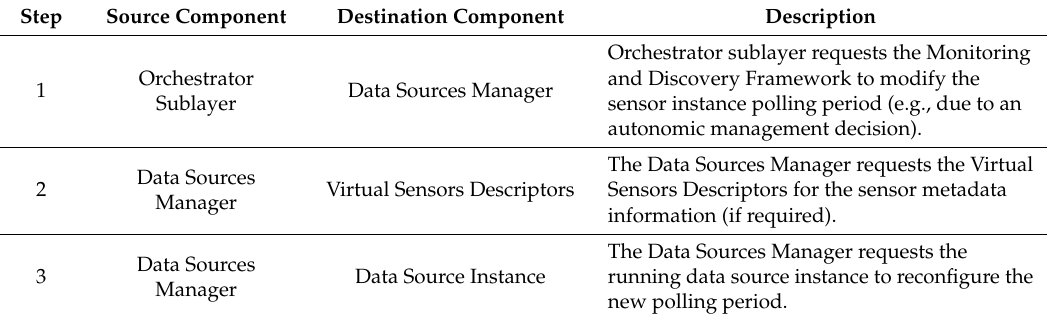
Table 8. Sensor Monitoring—Poll Metrics Workflow Steps.